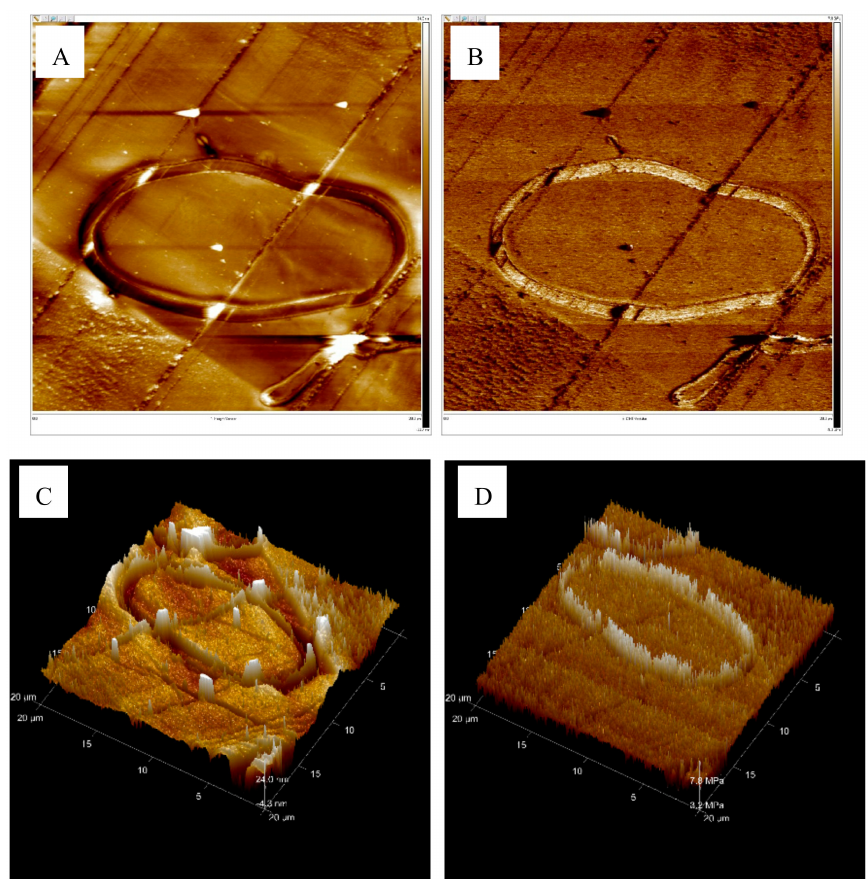
Figure 8. AFM observation of the cell wall modulus of a poplar catkin fiber (cross-section; size of 20 µ m × 20 µ m, ( A ) height image; ( B ) modulus image; ( C ) 3D height image; ( D ) 3D modulus